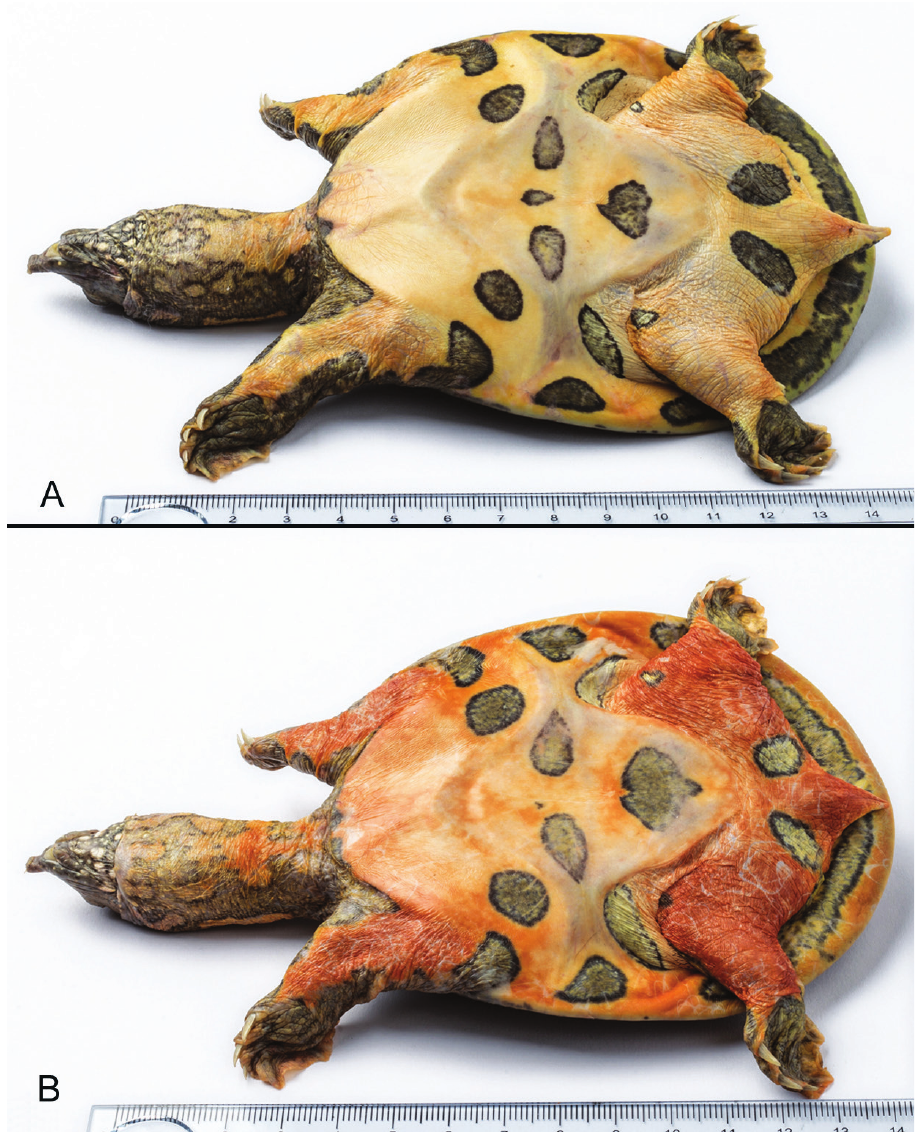
Figure 3. Plastral views of two freshly dead paratypes of Pelodiscus variegatus sp. n. A HNHM 2018.112.1, female, 77.4 mm PL B AQT001-HTVN2018, female, 77.3 mm PL. Photographs An Vinh Ong. al. 1991); and from P. parviformis , which has an unmarked yellowish white plastron at all ages. According to the specimens investigated and data available to us, P. variegatus also reaches a much smaller maximum size (23 cm CL; AMNH 28345) than P. maackii (at least 35 cm CL; Brandt 1857) but grows bigger than P. parviformis (16 cm CL; NMW 30232:6); P. sinensis (23 cm CL; ZMB 9784) and P. axenaria (20 cm CL;